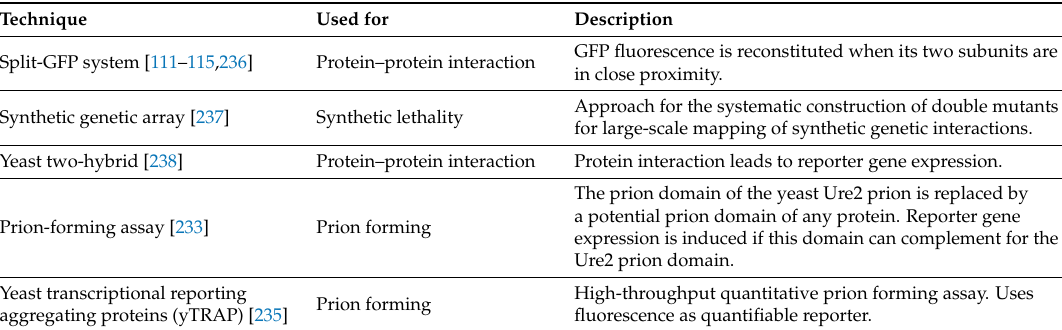
Summary of yeast-based techniques applicable in studies on proteins involved in neurodegenerative